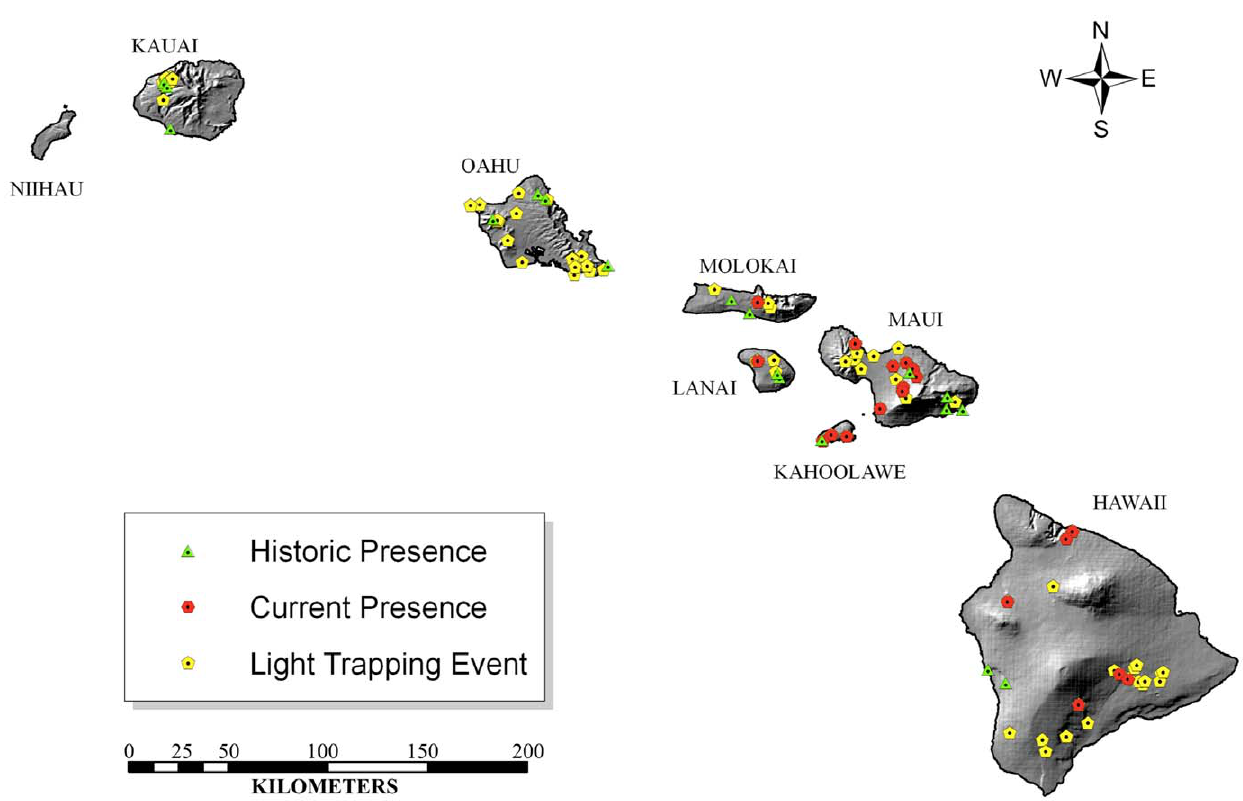
Figure 1. Map of historic and current O.continuatalis presence localities collected from around the Hawaiian Islands, as well as light trap collection localities where O.continuatalis were not observed during current surveys. These points were used to develop the Ecological Niche Models for each time period.